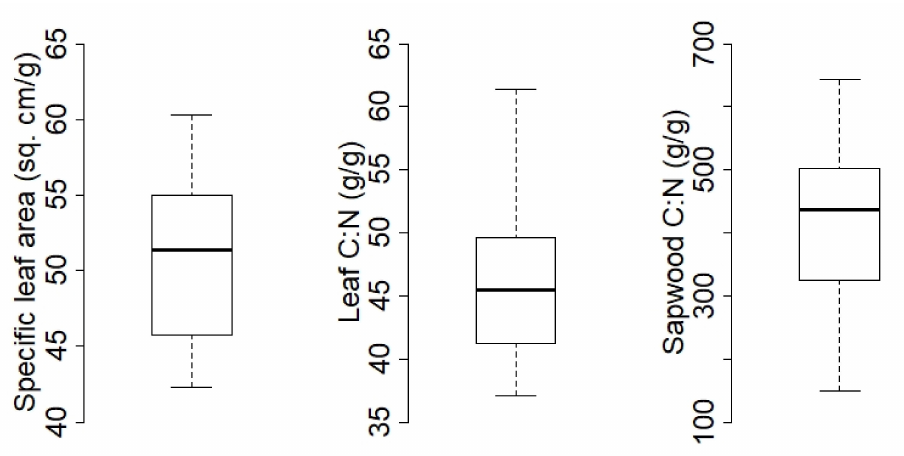
Figure 2. Boxplots of the morpho-physiological traits estimated in field.